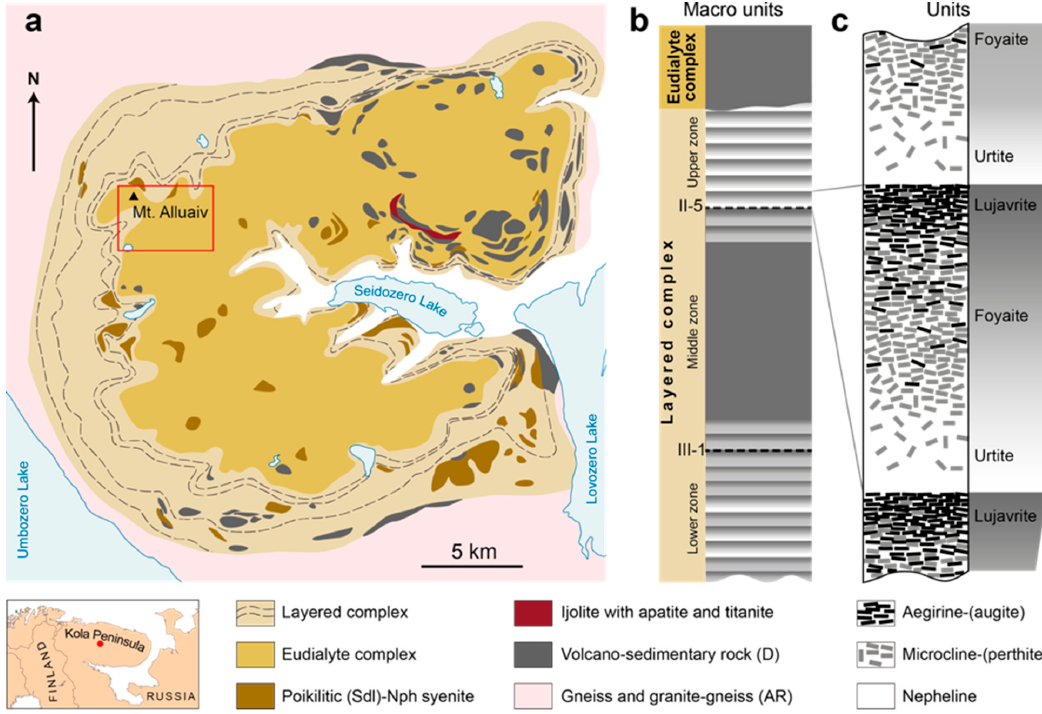
Figure 1. The geology of the Lovozero Alkaline Massif: schematic geological map, after [20] ( a ) and stratigraphic column [14] ( b ), with principal scheme of layering [21] ( c ).